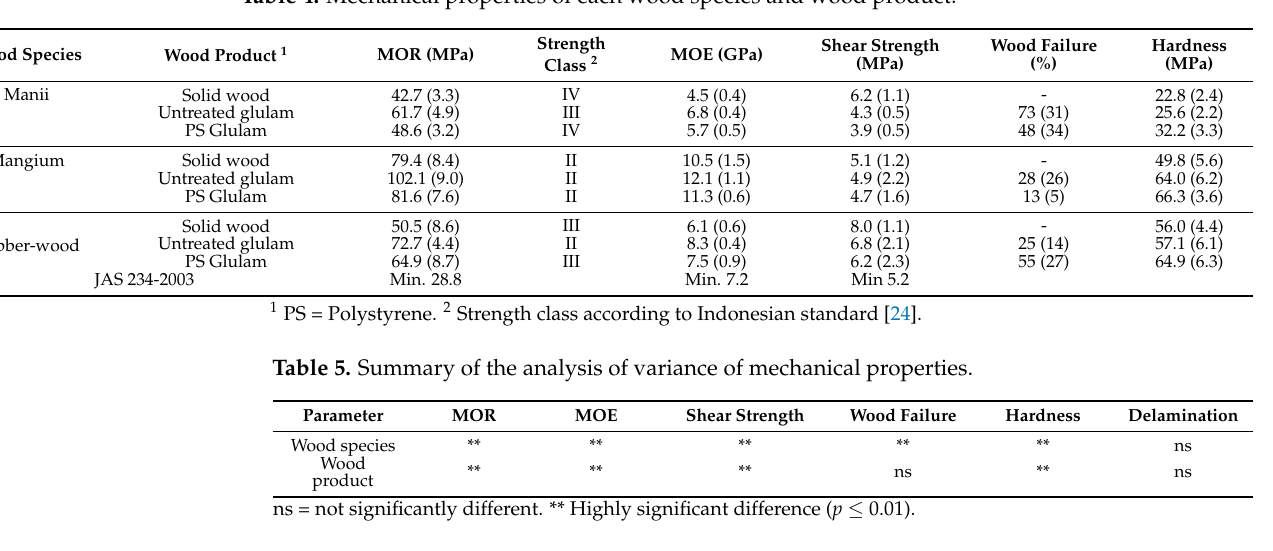
Table 6. Duncan’s multi-range test of mechanical properties. Table 5. Summary of the analysis of variance of mechanical properties.